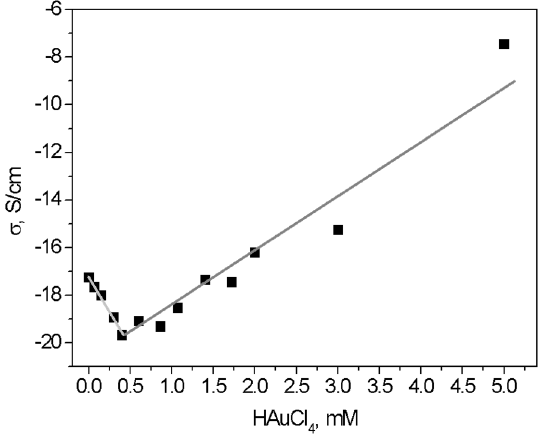
Figure 7. Dependence of DC conductivity of films at room temperature on the concentration of HAuCl 4 (lines a guide to the eye).